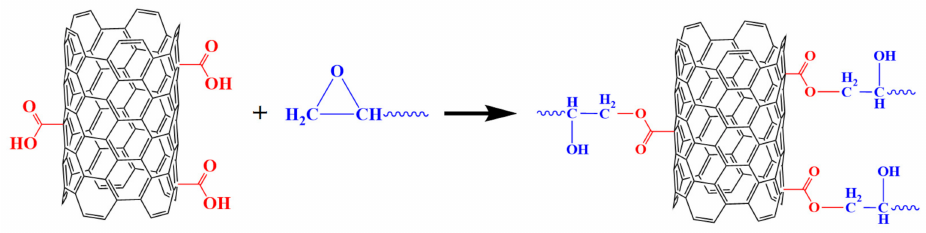
Figure 2. Schematic illustration of the nanocomposite structures of functionalization MWCNTs and